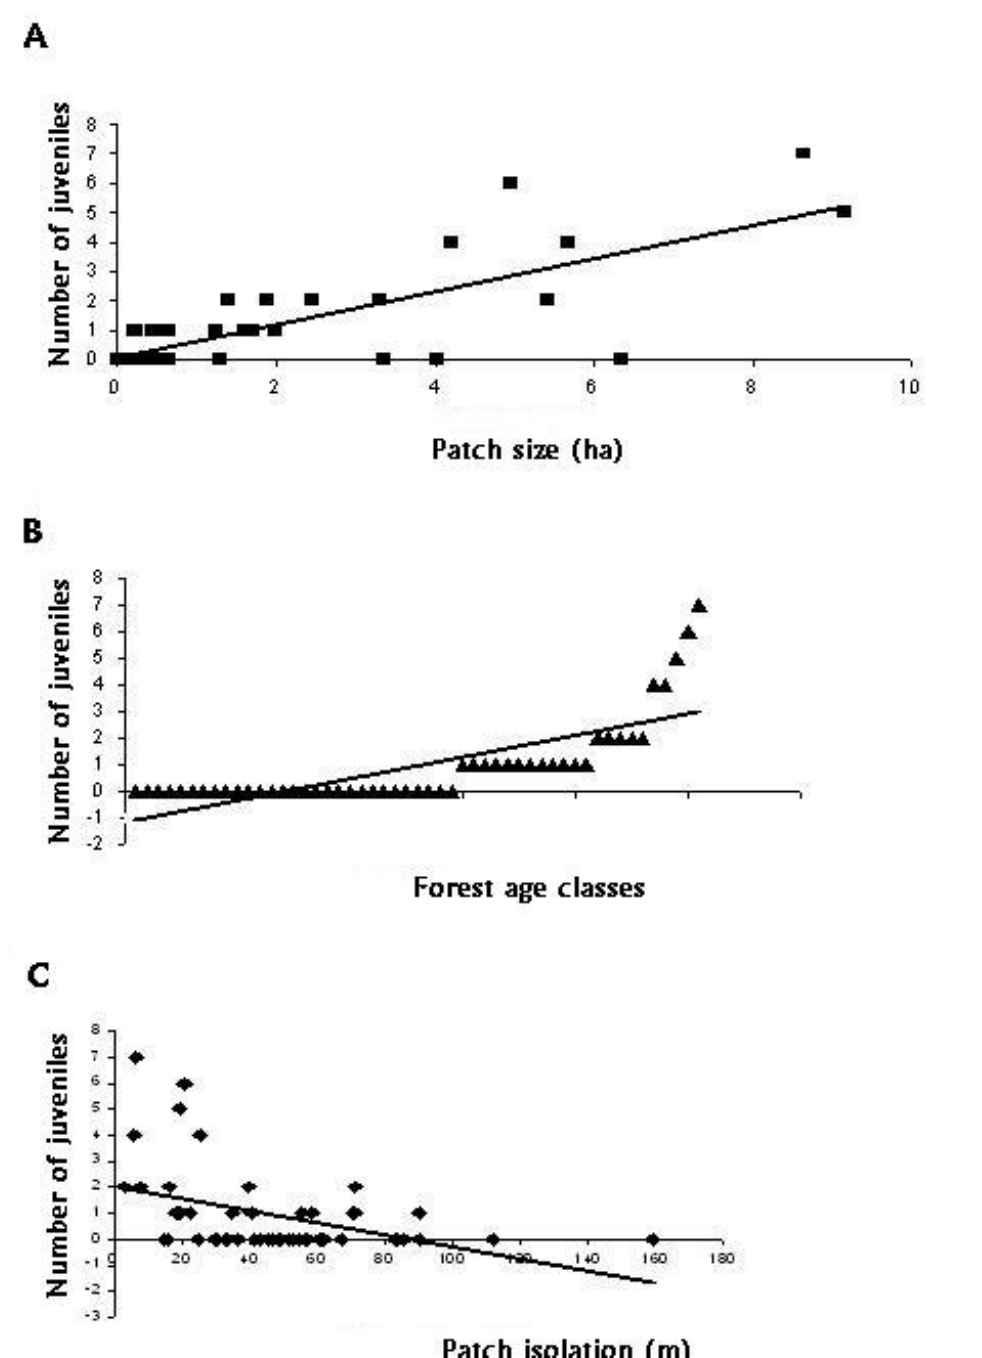
Fig. 2 . Correlations between the three environmental predictors influencing natal dispersal of the North Island robin: A) patch size, B) age class, and C) patch